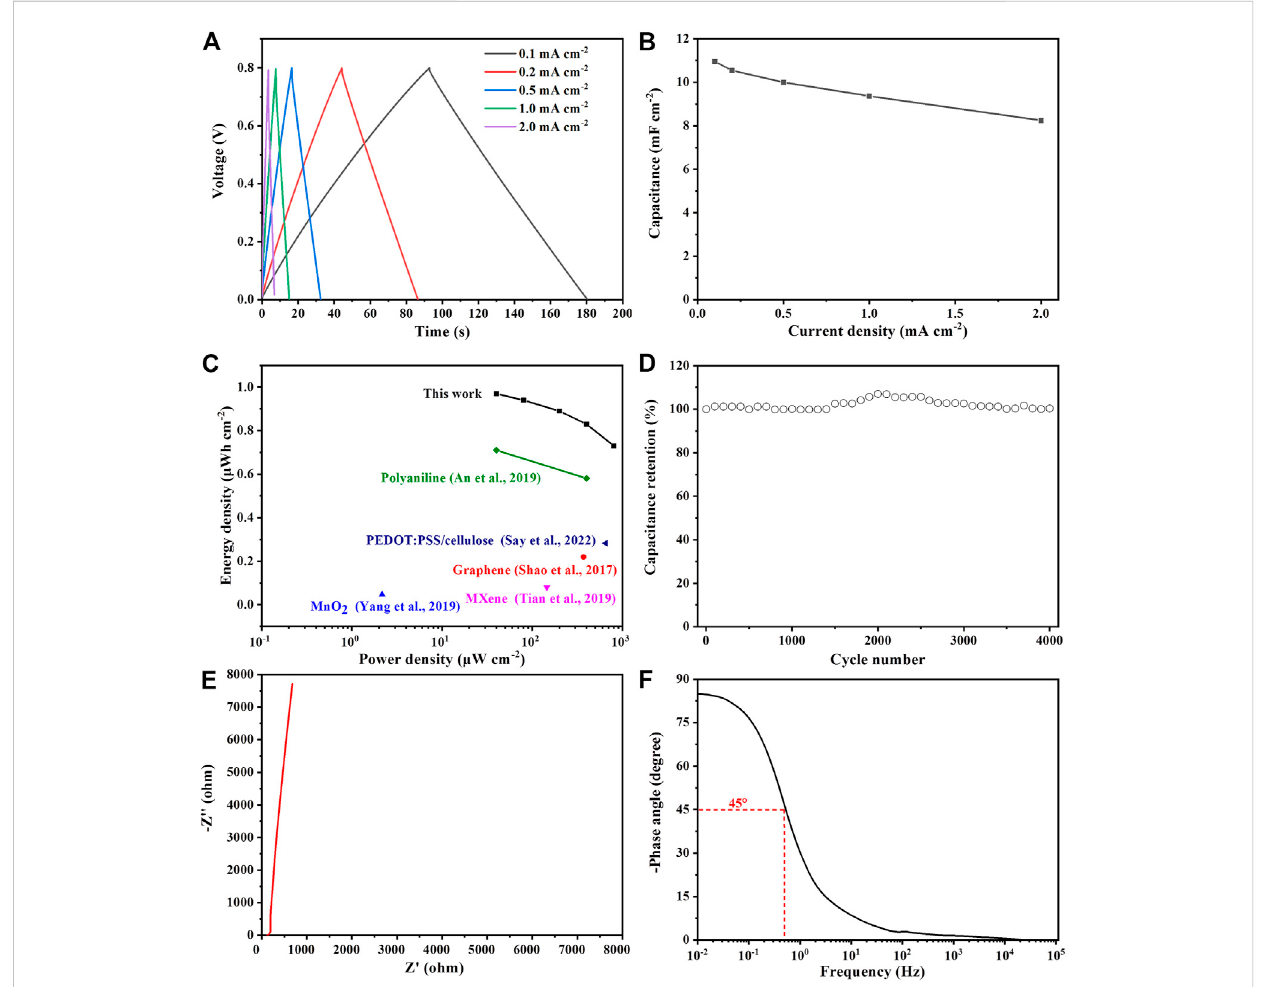
FIGURE 5 Electrochemical performance of the MSC-150. (A) GCD curves and (B) areal speci fi c capacitances at different current densities. (C) Comparison of energyandpowerdensitywiththatofpreviouslyreported fl exibleMSCs. (D) Cyclingperformanceat1 mAcm − 2 for4,000cycles. (E) Nyquistplot. (F) Bode